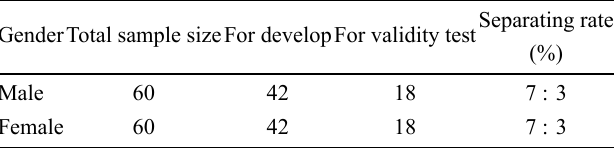
Table 2. Divided sample size according to Bernoulli’s